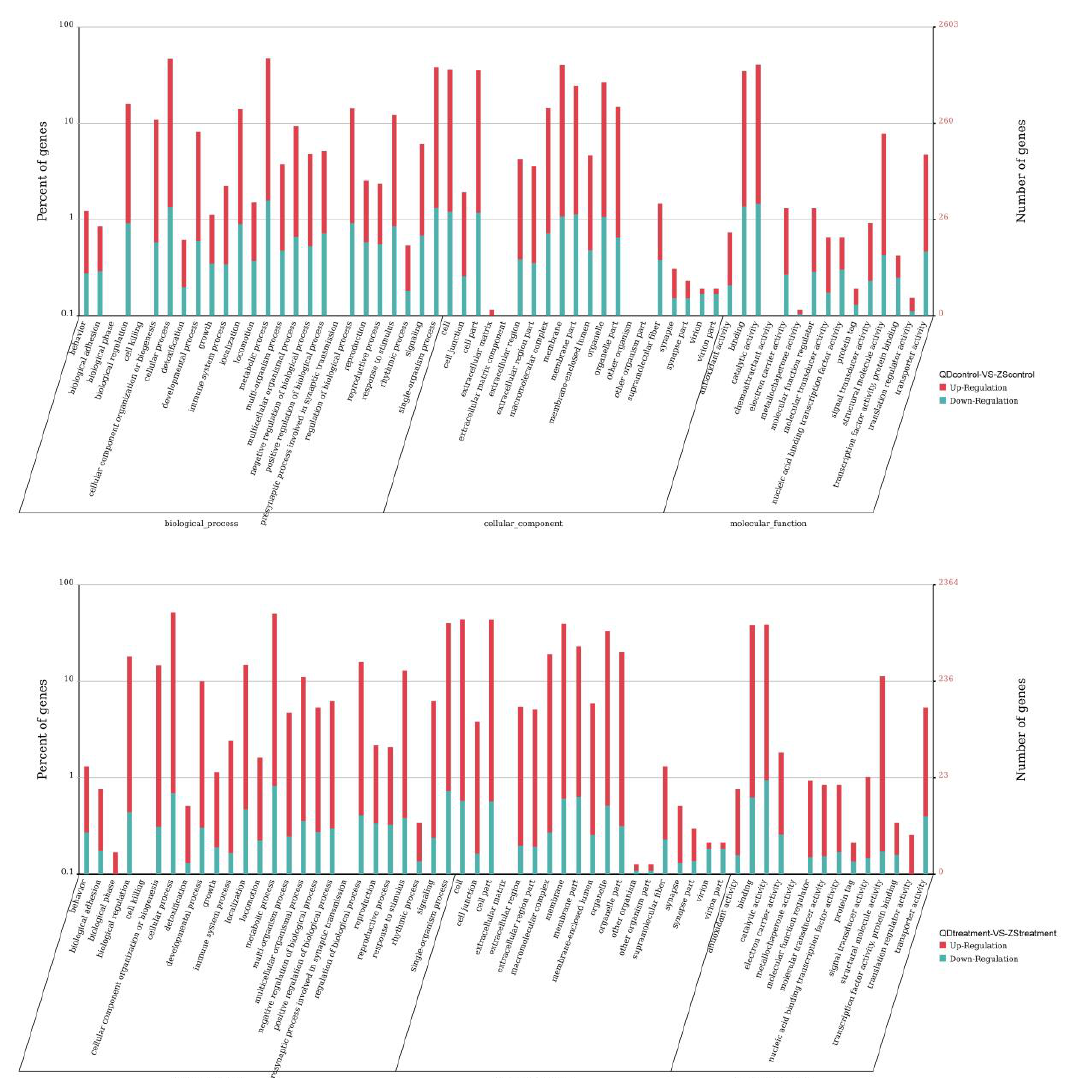
Figure 4. Results of the enrichment analysis of Gene Ontology (GO) terms of the differentially expressed unigenes between two populations (ZS control : Zhoushan population at 20 °C; ZS treatment : Zhoushan population at 28 °C; QD control : Qingdao population at 20 °C; QD treatment : Qingdao population at 28 °C).